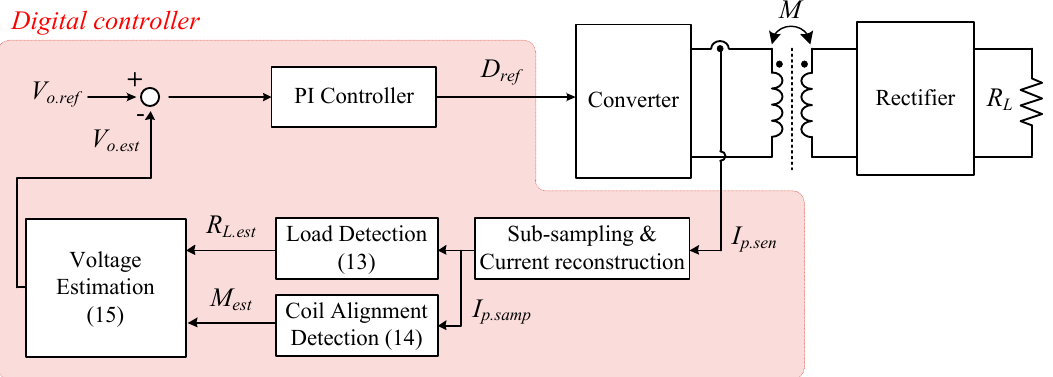
Figure 6. Block diagram of the proposed digital control method.